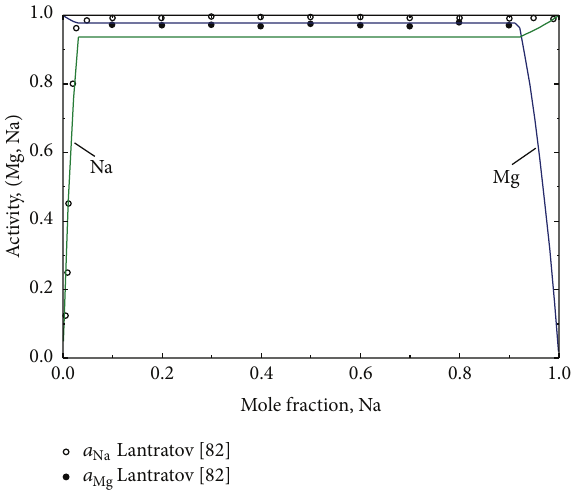
Figure 11: Calculated PCIs for NaMgH 3 at various temperatures compared to experimental data reported by Sheppard et al. [88].